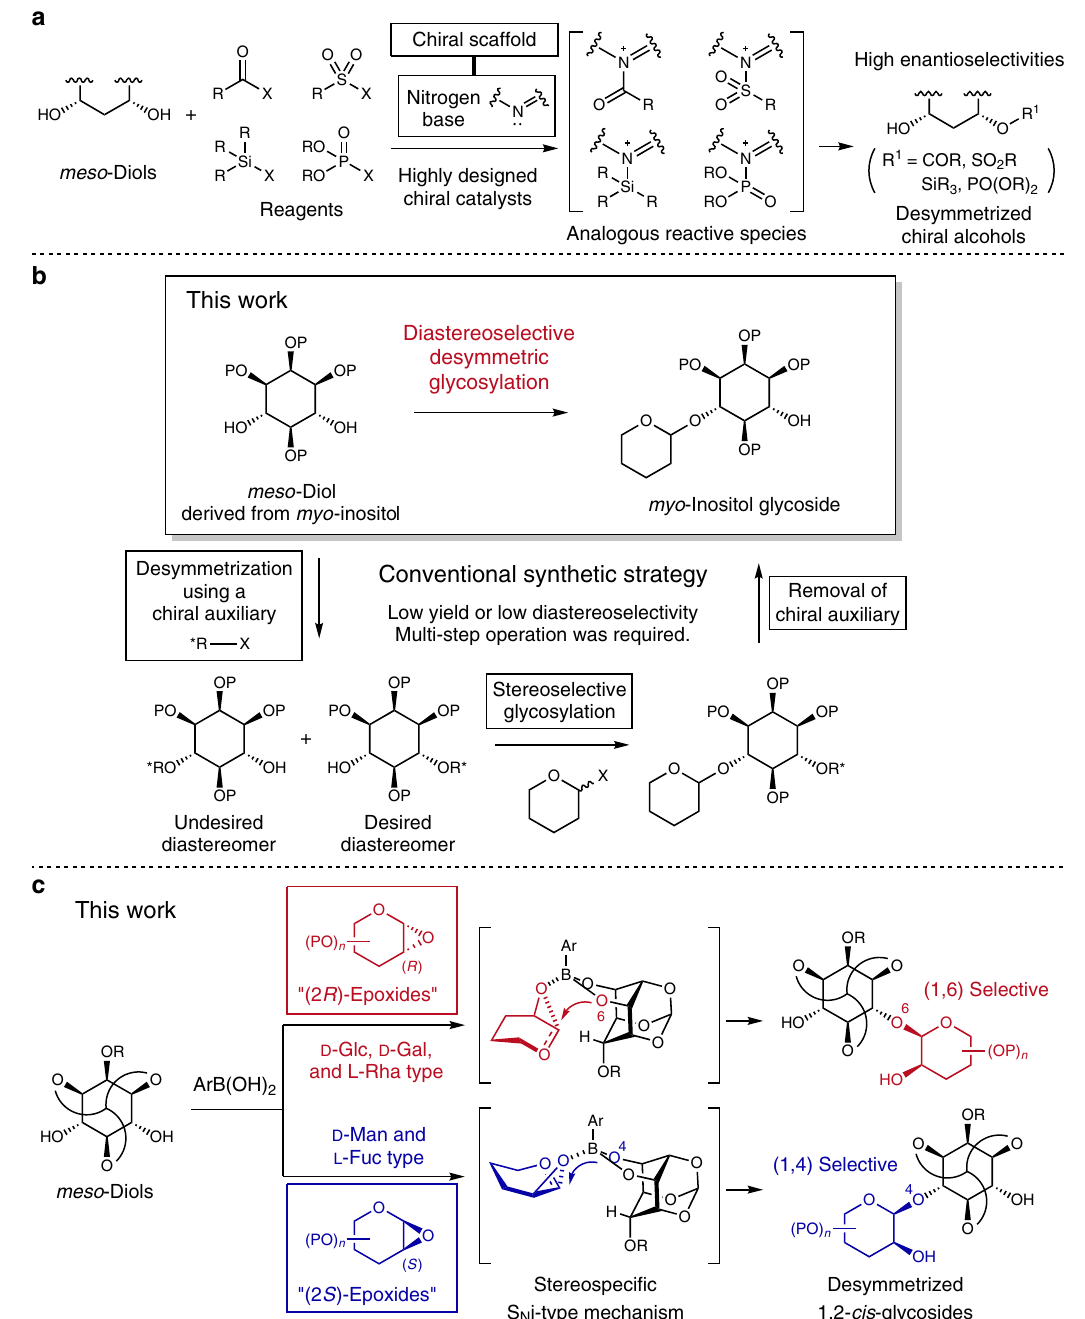
Fig. 1 Enantio- or diastereoselective functionalizations of meso -diols. a Highly enantioselective functionalizations of meso -diols using highly designed chiral catalysts. b Synthetic strategy for myo -inositol glycoside from a meso -diol. c Boronic-acid-catalyzed desymmetric 1,2- cis -glycosylations of meso -diols. X leaving group, P protecting group, Ar aryl, Glc glucose, Gal galactose, Rha rhamnose, Man mannose, Fuc